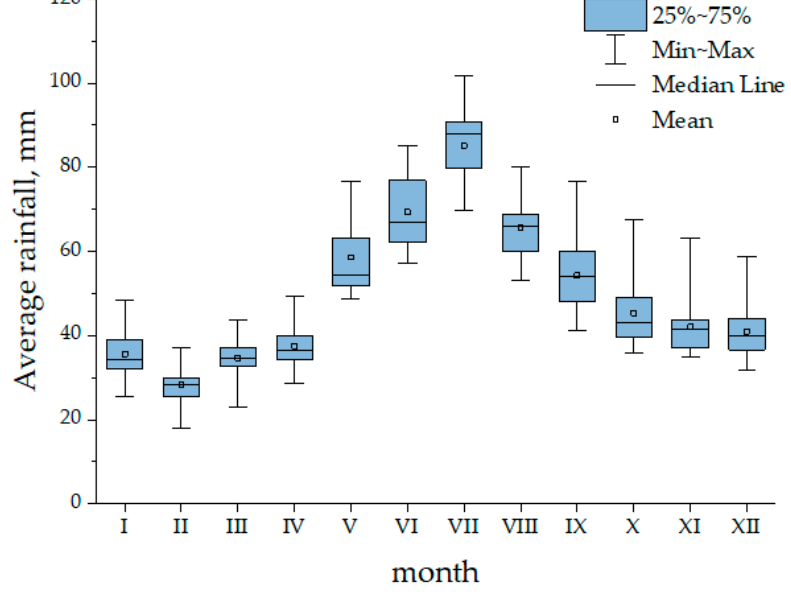
Figure 4. Average monthly rainfall amounts in analysed cities. Table 1. Determining factors of four analysed cases of residential RWH